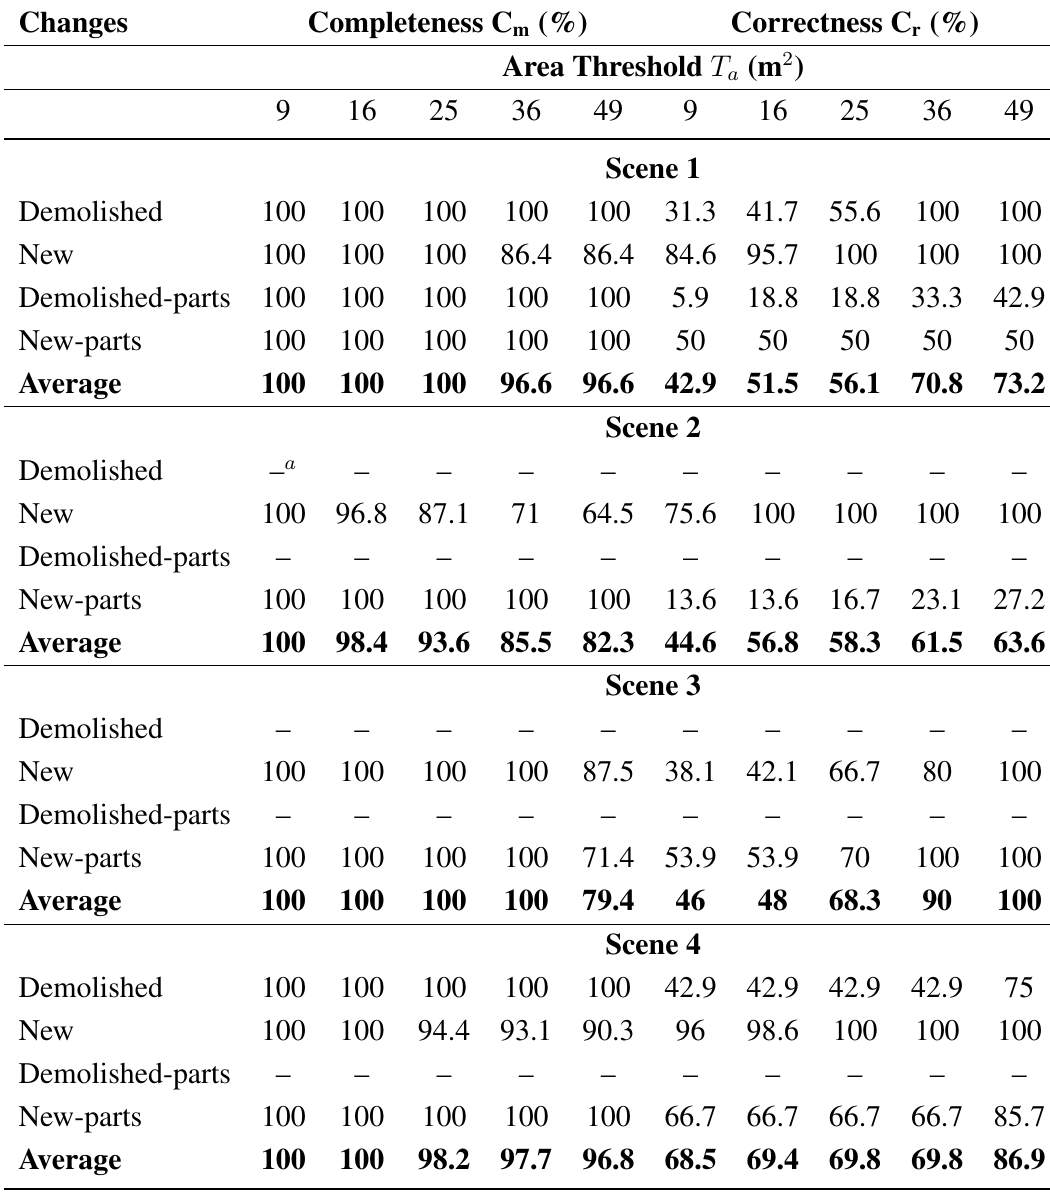
Table 2. Completeness and correctness of the change detection technique at different area threshold